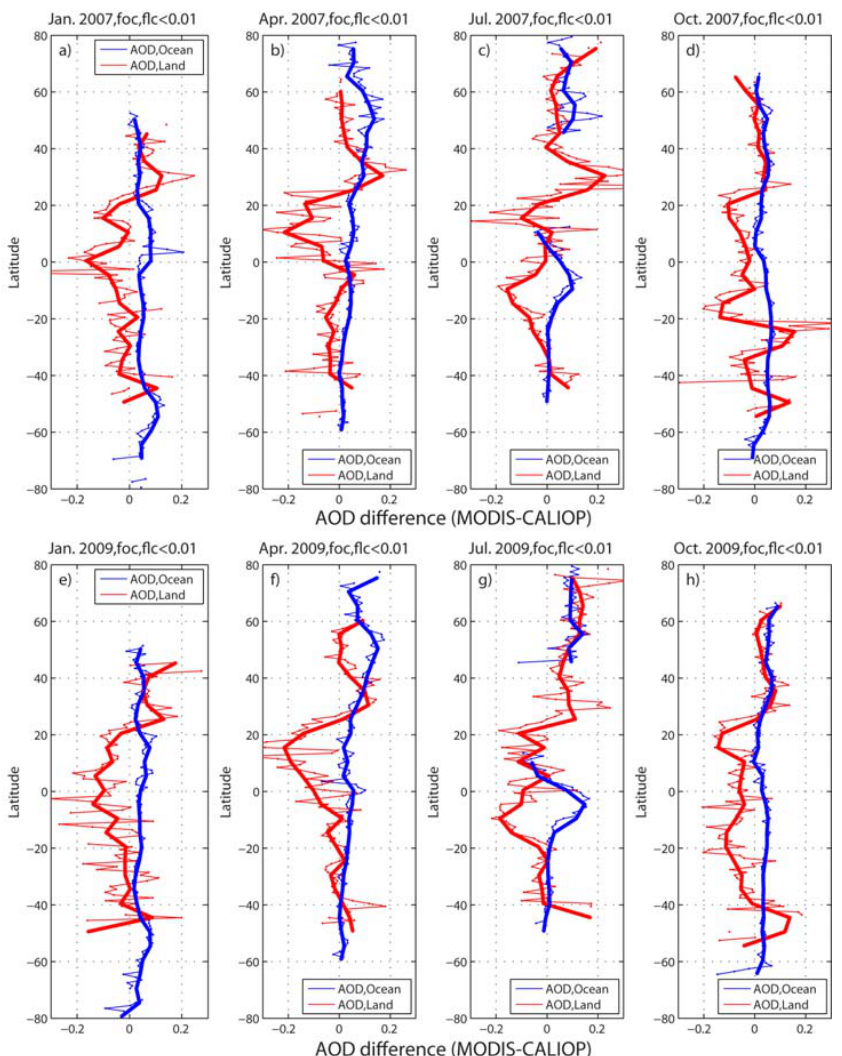
Fig. 7. Same as Fig. 6, but for the more severely cloud-screened data, as described by comparison #4 in Table 1. foc: cloud fraction over ocean; flc: cloud fraction over